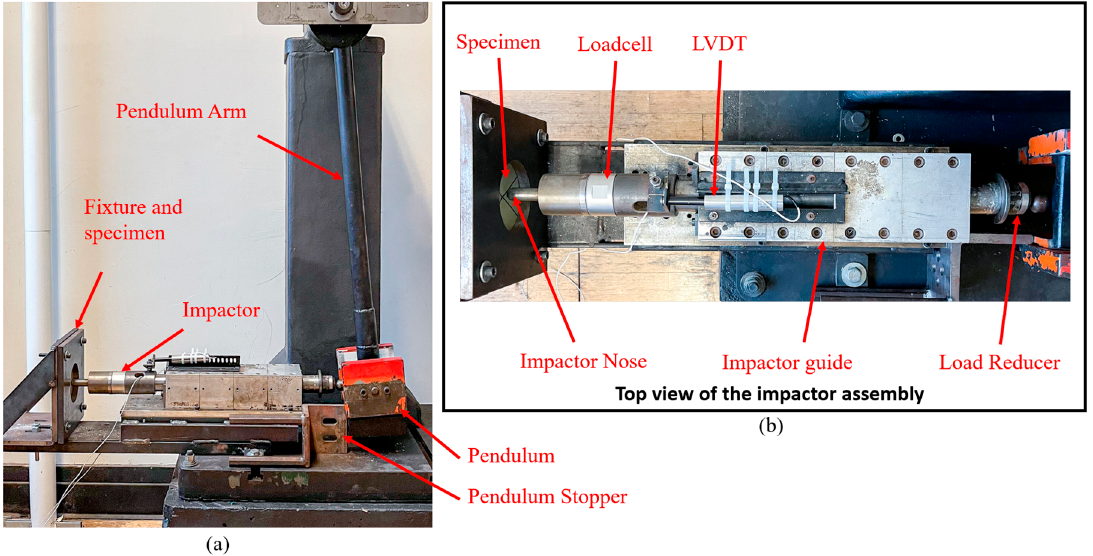
Figure 2. Low-velocity impact test setup. ( a ) Overview of the impact equipment; ( b ) a close-up view of the impactor assembly.